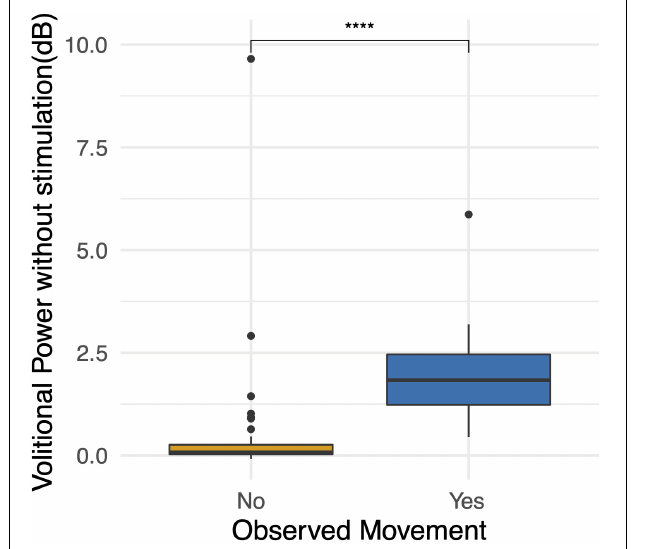
FIGURE 6 | Observations during BMCA. Differences in volitional power without stimulation (dB) when movement was observed and recorded on case report forms. High volitional power outliers when movement was not observed demonstrate the lower sensitivity of researcher observations. For reference, volitional power of 3 dB represents an increase in muscle activity during volitional tasks of two times (200%) that of muscle activity at baseline. Volitional power of 10 represents an increase in muscle activity during volitional tasks of 10 times (1000%) that of the muscle activity at baseline. *** p < 0.001.